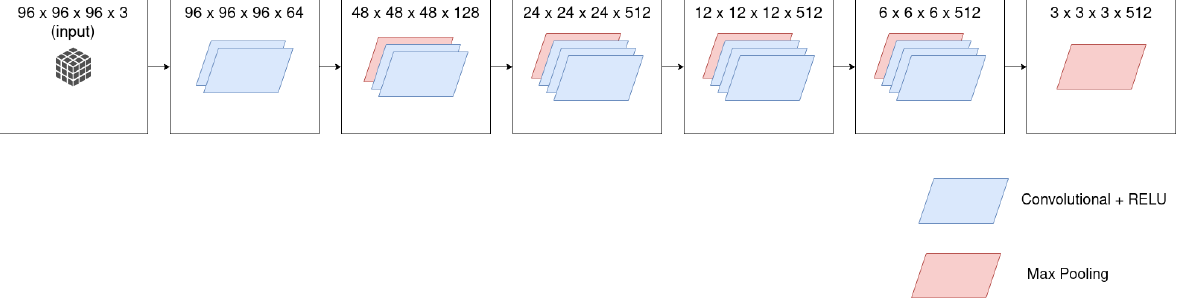
Figure 5. VGG16 architecture.